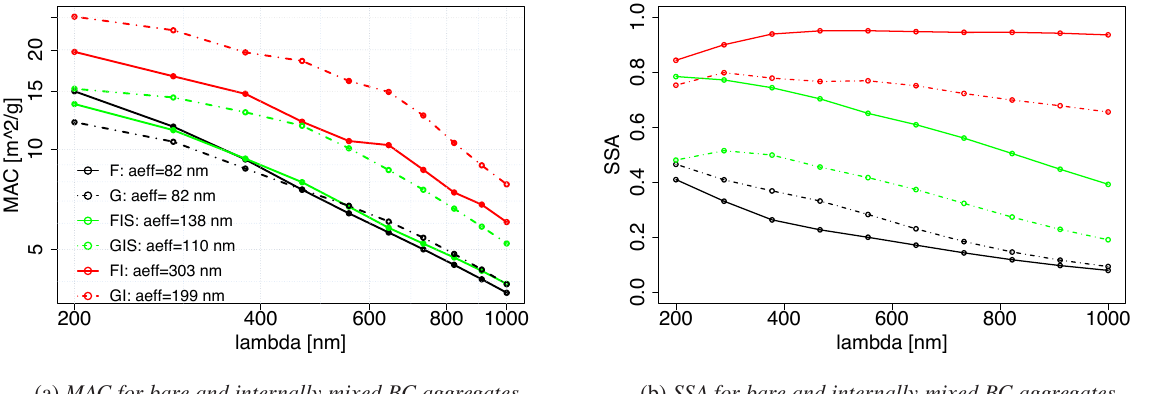
Fig. 7. (a) MAC in log-log scale and (b) SSA for different of bare BC and BC mixed with NaCl (see Table 2 and Figs. 5, and 6). The refractive index ( m ) of BC and NaCl has been considered constant in the spectral range between 200 and 1000nm, where m BC = 1 . 95 − 0 . 79 i and m NaCl = 1 . 5 and the density of BC ( ρ BC ) is 1.8gcm − 3 . All the computed optical values are averaged over 1000 particle orientations and satisfy the condition | m | kd < 0 . 3. The spectral resolution is 100nm.